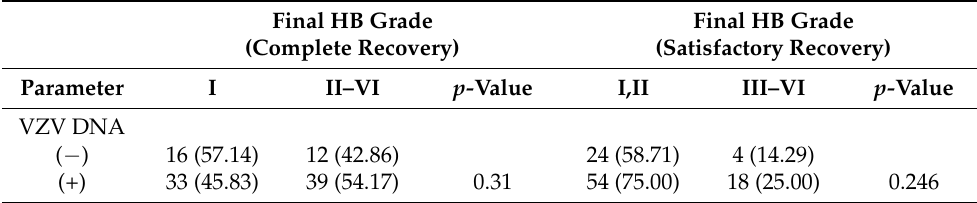
Table 4. Differences in complete and satisfactory recovery between the salivary VZV DNA-positive and negative groups.